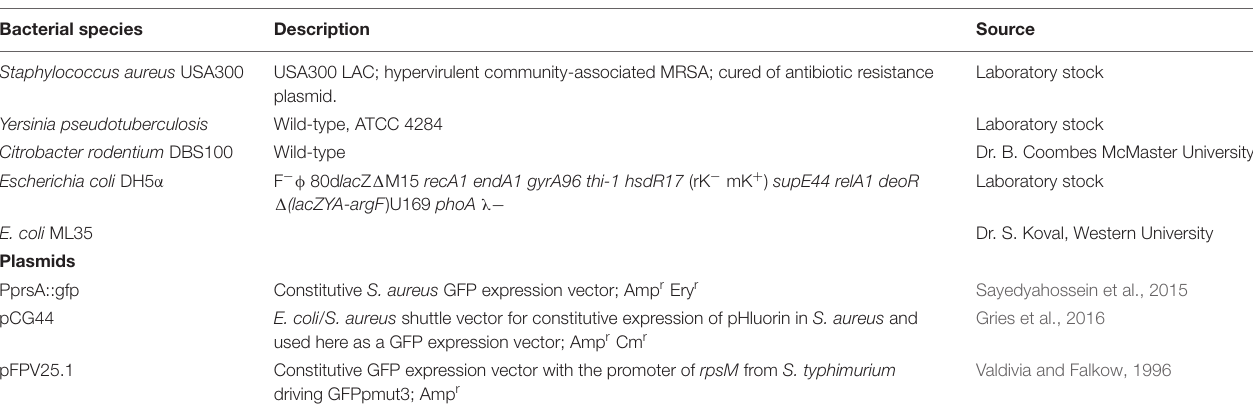
FIGURE 1 | Schematic representation of the eFluor-proliferation assay. When setting up an infection GFP bacteria (or a red fluorescent protein) are incubated with amine-reactive eFluor TM -670 rendering the bacteria positive for both fluorophores. These double positive bacteria are incubated with macrophages and after phagocytosis and treatment with gentamicin, infected macrophages are imaged by fluorescence microscopy. The appearance of bacteria that are GFP-positive yet eFluor TM -670-negative indicates that bacterial replication has occurred. In contrast, bacteria that remain positive for both fluorophores have not replicated. Through replication, the proliferation dye becomes increasingly diluted between daughter cells and is eventually undetectable. TABLE 1 | Bacterial species and